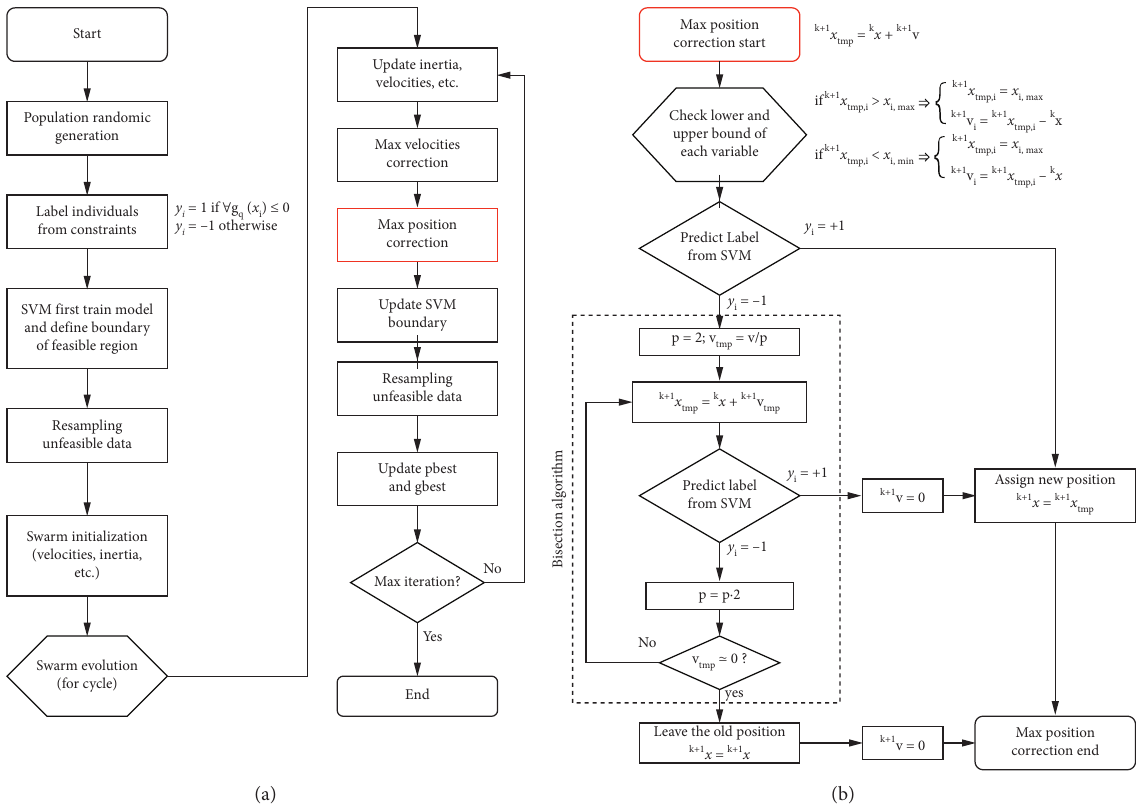
Figure 1: Flowchart of the proposed PSO-SVM algorithm. (a) General flowchart of the proposed algorithm; (b) flowchart of “Max Position Correction”